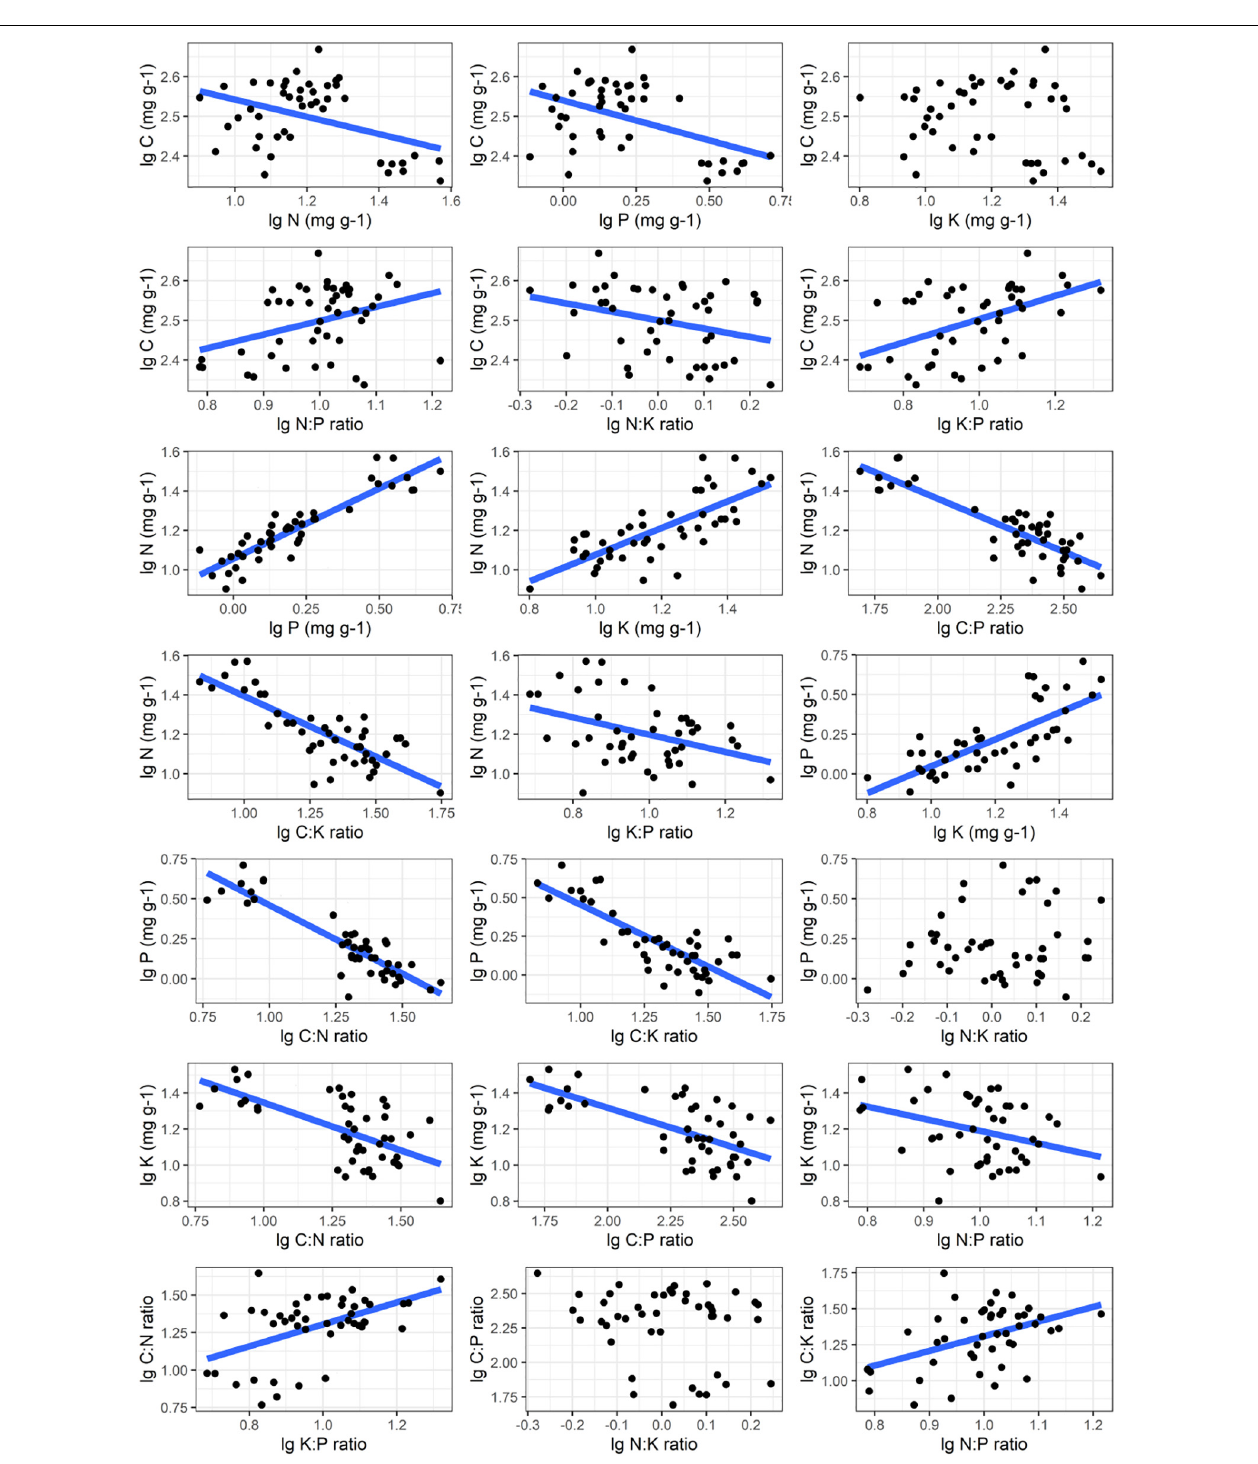
FIGURE 4 | Nutrient stoichiometric relationships of Carex schmidtii . The relationships between C, N, P, K and the corresponding ratios of C. schmidtii are fitted.